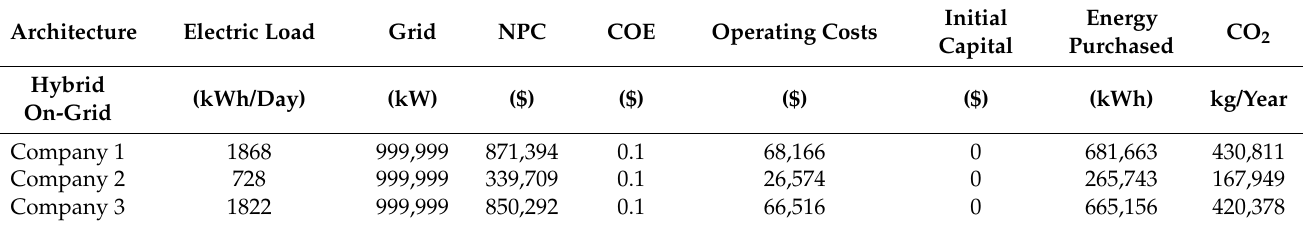
Table 3. On-grid system for the lead companies (Fez Region).